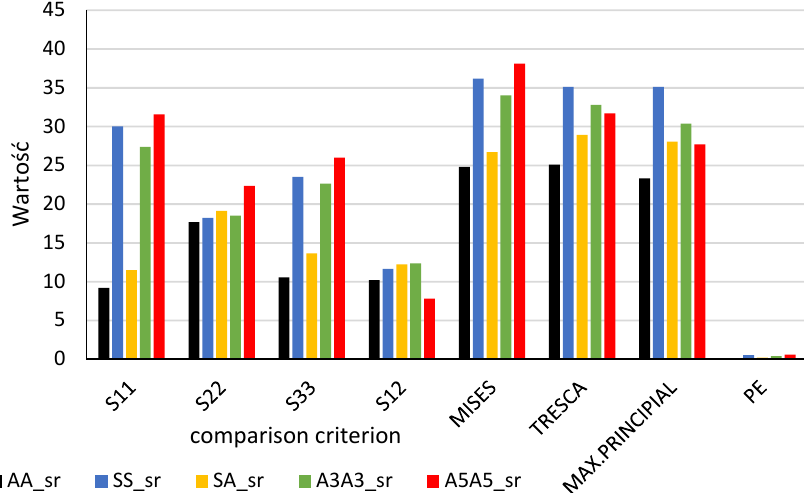
Figure 29. Comparison of the maximal values of potential failure criteria for the considered types of joints (results for the adhesive middle part).